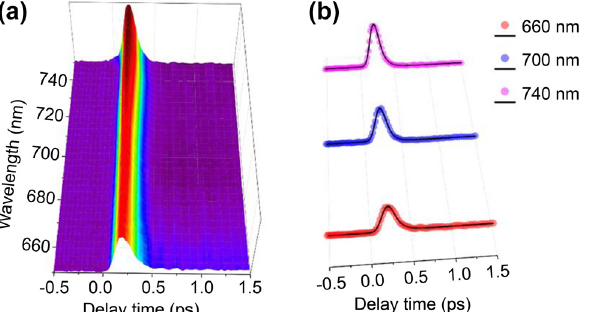
Figure 4: Ultrafast exciton dynamics at 650 – 750 nm. (a) TA spectrum of MXene versus the probe wavelength and pump- probe delay time. (b) Ultrafast dynamics at the probe wavelength of 660, 700, and 740 nm, the black solid lines are fi tted by mono- exponential function.